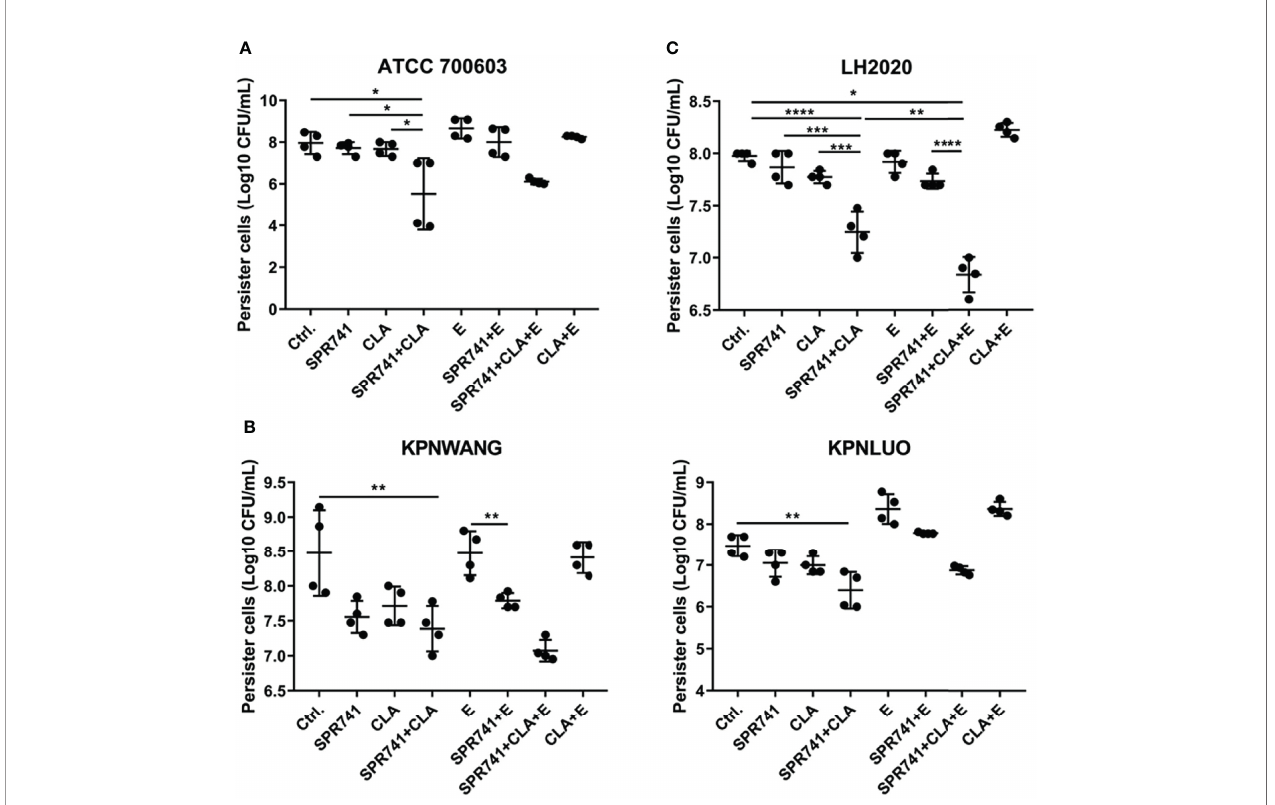
FIGURE 4 | SPR741 combined with CLA and E shows strong bactericidal activity against CCCP-induced K. pneumoniae persister cells. Viability of K. pneumoniae ATCC 700603 persister cells exposed to 8 µg/mL SPR741, 16 µg/mL CLA, and16 µg/mL E for 6 h;the control group was leftuntreated (A) ; The killing effect of 16 µg/mL SPR741, 32 µg/mL CLA, and 32 µg/mLE onXDR K.pneumoniae KPWANG and KPLUO (B) and PDR K. pneumoniae LH2020 (C) persister cells. Data are presentedas mean ± S.Dand analysedby Dunn ’ s multiplecomparison test. Experiment was repeatedfourtimes. *p < 0.05; **p < 0.01; ***p < 0.001; ****p <